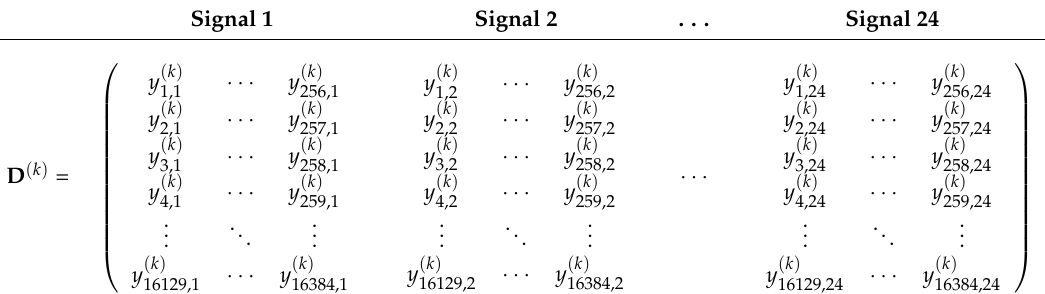
Table 3. Synthetic data augmentation for experiment k , k = 1, . . . , K